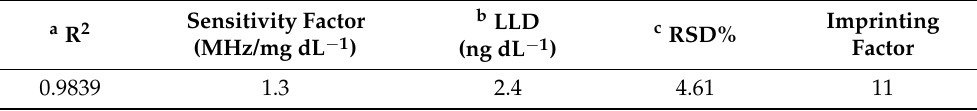
a Square Correlation Coefficient, b Lower Limit of Detection, c Relative Standard Deviation.